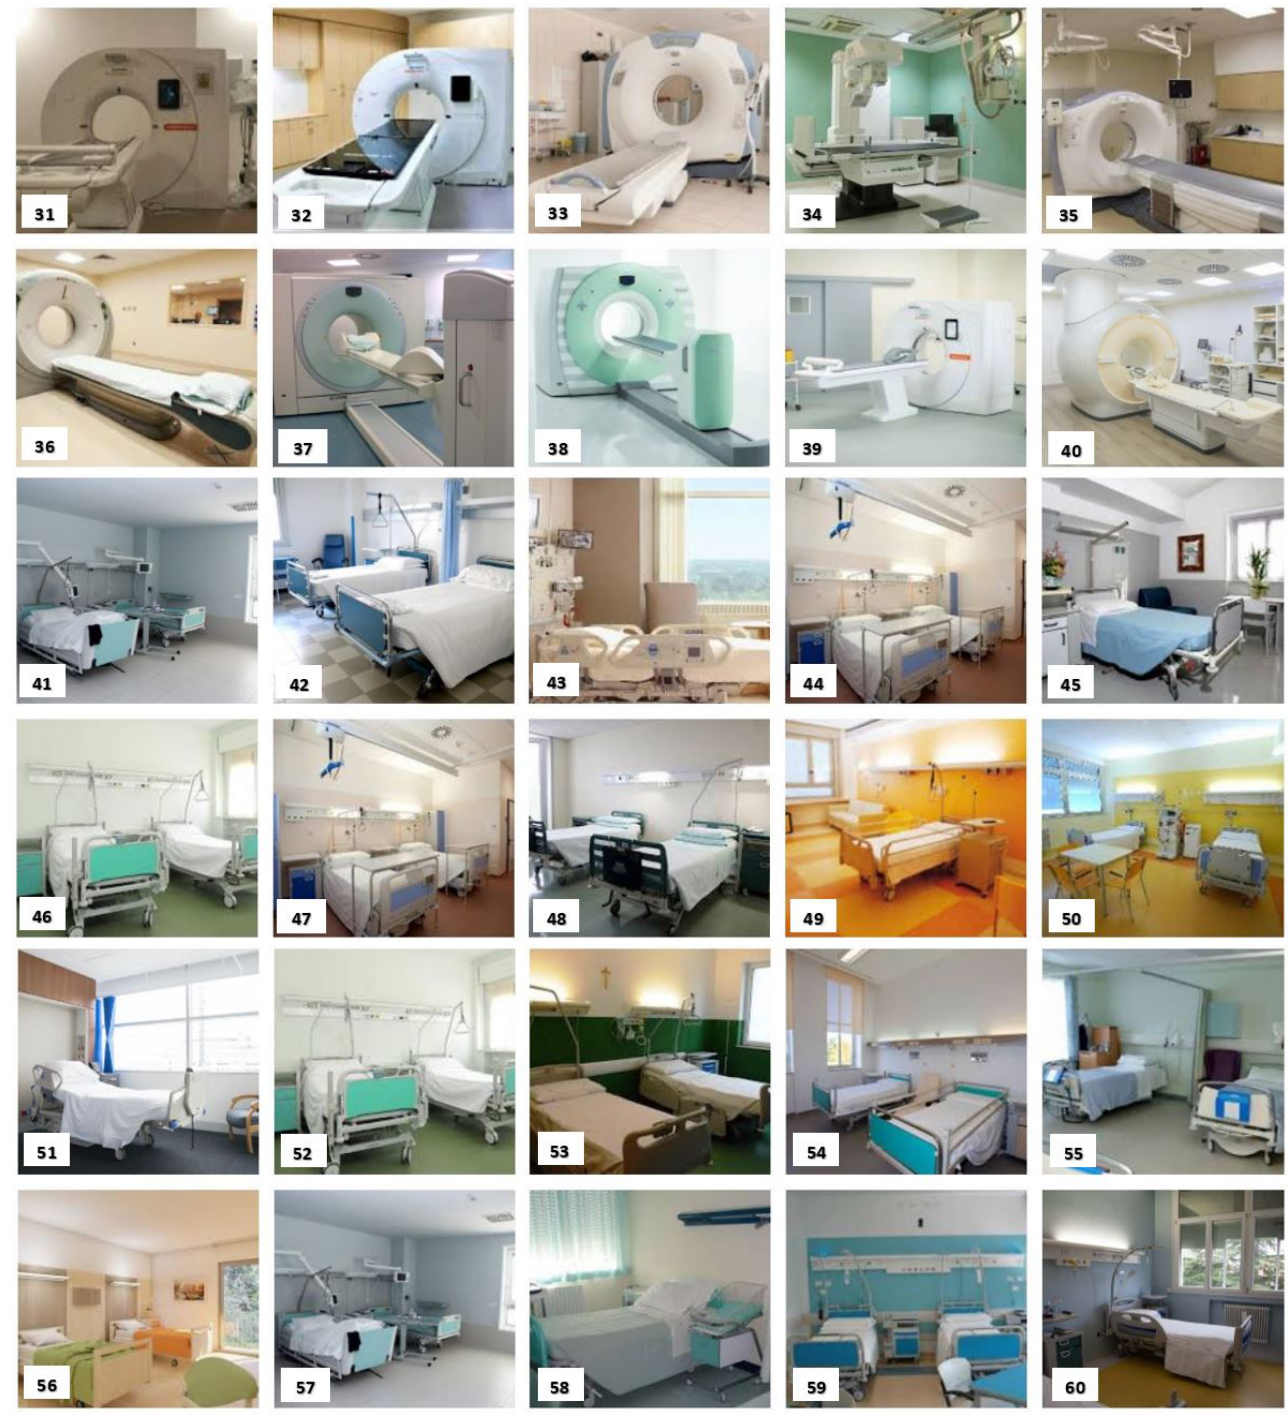
Figure A2. The images used in the test sets (31 to 40) of both custom models for the “diagnostic and therapeutic radiology” IU and the images used in the training sets (41 to 50) and test sets (51 to 60) of both custom models for the “hospitalisation” IU (from Google